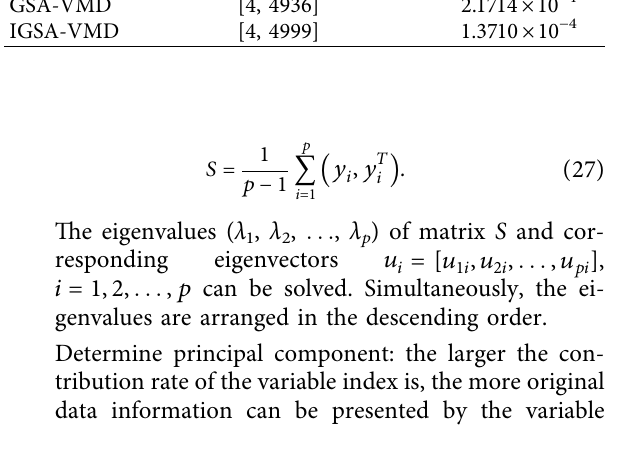
Figure 6: Optimal fitness value iteration curve of the simulated signal. Table 1: Optimization results of the simulated signal.